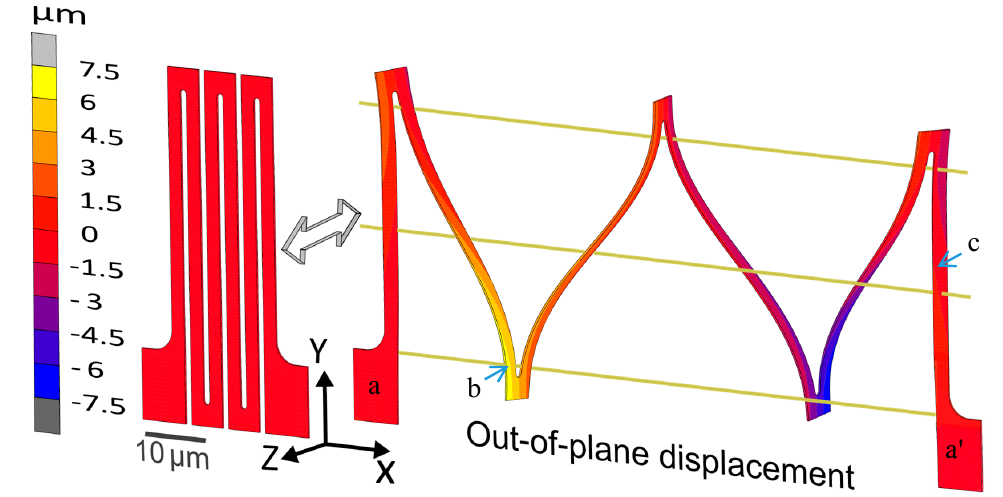
Figure 3. Finite element method (FEM) simulation of an interconnect design, showing: ( left ) Initial unloaded structure; ( right ) Stretched interconnect structure, with an out-of-plane displacement field ( U z ) overlaid on top. Note that the two ends marked a and a’ always remain in the initial interconnect plane (i.e., U z = 0), along with the three parallel gold-colored solid lines. Point b and c denote the location of σ max and τ max ,